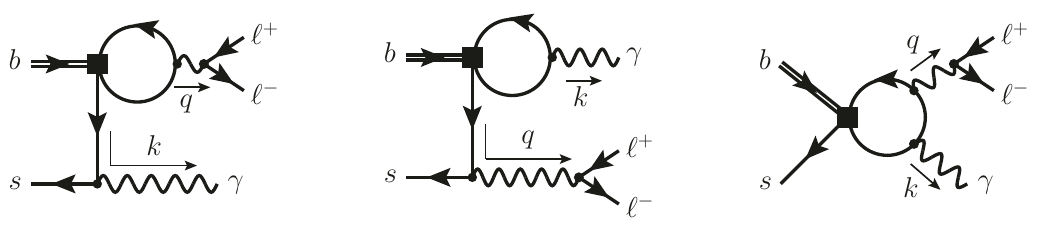
Figure 1 . The three possible contractions ( A -type left, B -type middle) of the four-quark operators P 1 ,..., 6 at O ( α 0 ) . The insertion shown on the right is power-suppressed. The B -type insertion is s power-suppressed when q 2 ∼ m 2 but LP when q 2 ∼ E γ Λ QCD , m b Λ QCD . For the first two diagrams, b there exists a counterpart where the real/virtual photon is attached to the heavy-quark line (double line), which, however, is power-suppressed. The external photon line with momentum k symbolizes the electromagnetic current j µ ( x ) in the definition (2.11) of the hadronic tensor T µν f photon including its decay into the lepton-pair graphically represents the current j µ